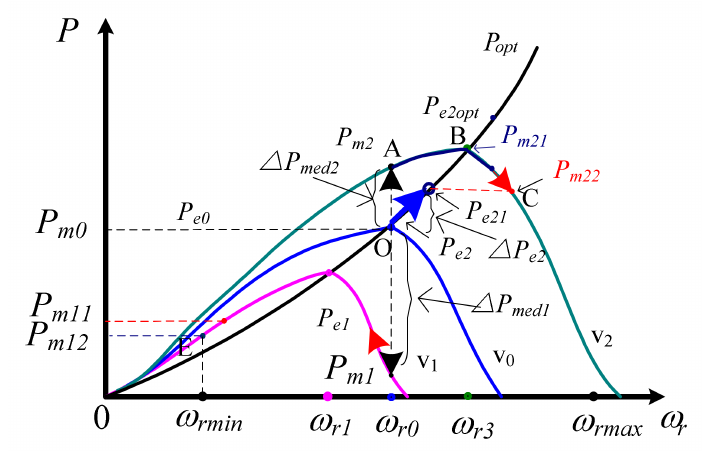
Figure 8. Mechanical input power and electromagnetic output power curve of the DFIG under different wind